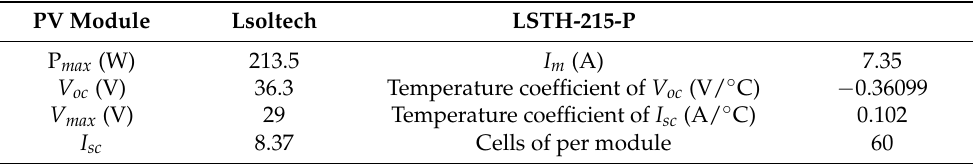
Table 2. Photovoltaic module related